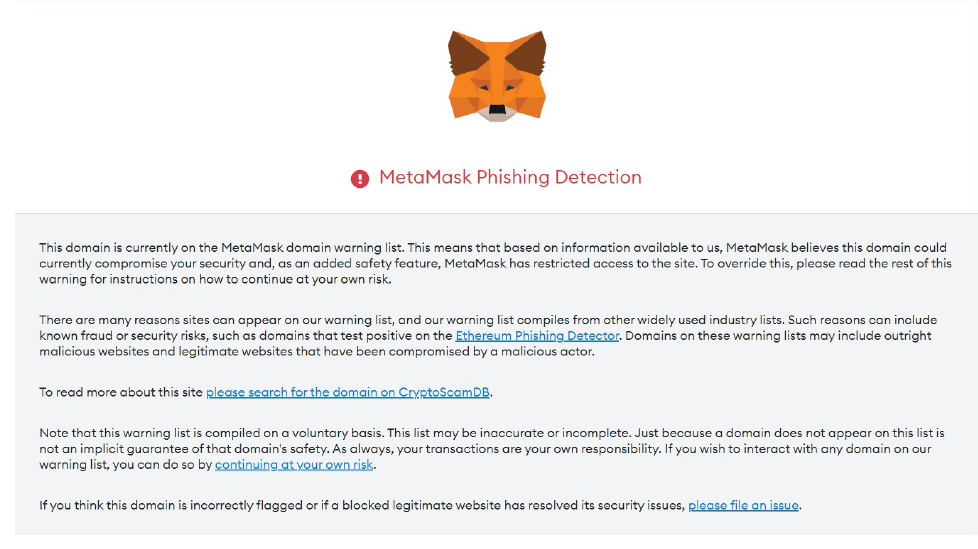
Figure 31. Metamask app warning to the user.